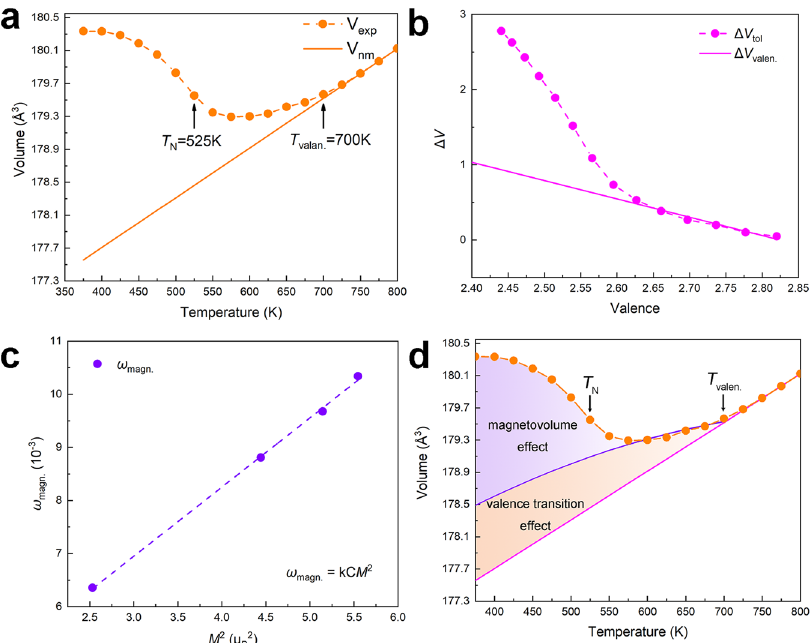
Fig. 4 The enhanced NTE induced by the dual effect. a Experimental unit cell volume ( V exp ) determined by SXRD and nominal volume ( V nm ) estimated from the phonon vibrations contriution. b Volume difference ( Δ V tol = V exp − V nm ) plotted as function of Yb valence and valence transition contribution ( Δ V valen. ) to NTE. c Correlation between M 2 and ω magn. . d The dual effect of magnetism and valence transition to the NTE of